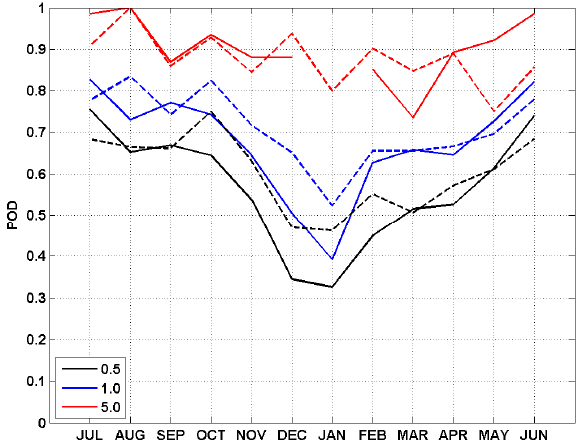
Fig. 5. Monthly POD as computed using three detection thresholds: 0.5 (black), 1.0 (blue), and 5.0 (red) mmh − 1 . Solid and dashed lines indicate OPEMW results as compared with RGN and RNC, respec- tively. The value for RGN at 5mmh − 1 threshold is missing in Jan- uary due to insufficient data points.